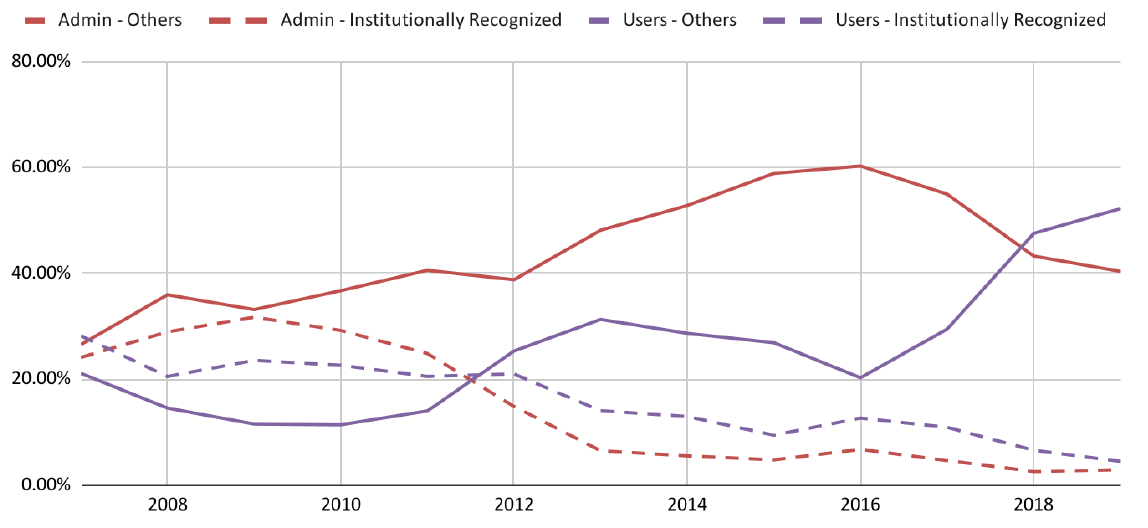
Figure 6. Distribution of questions that users and administrators asked to be referred to a recognized rabbi versus a less well-known rabbi.